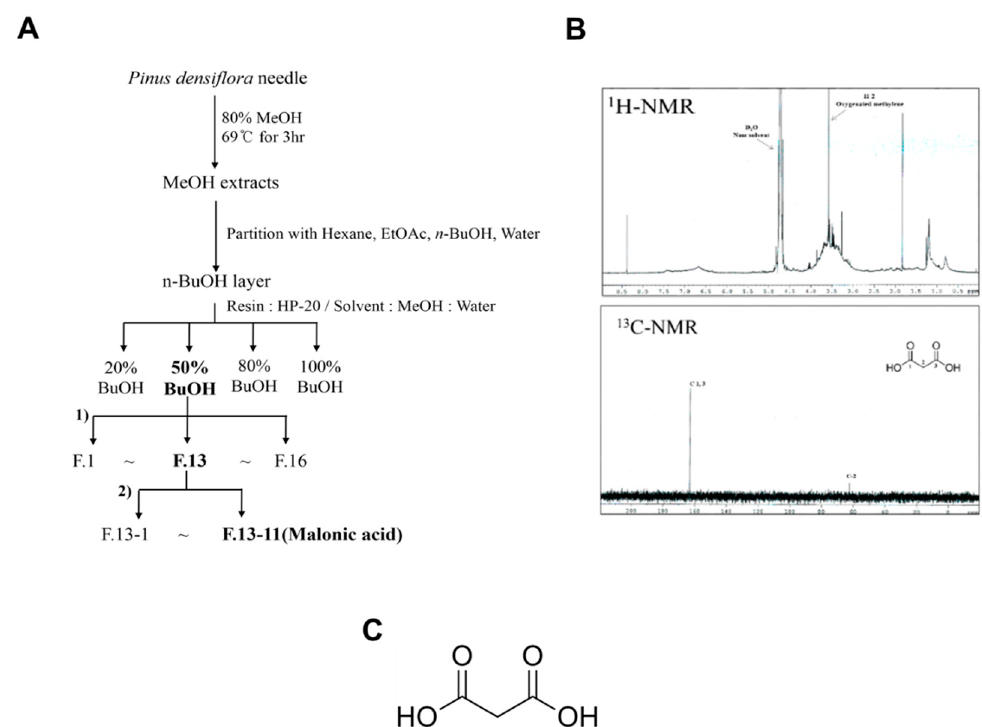
Figure 1. Isolation and purification of malonic acid (MA) from P. densiflora. ( A ) The P. densiflora n-BuOH layer has been separated and identified by nuclear magnetic resonance (NMR) to be MA. ( B ) 1H-NMR (300 MHz, D 2 O, δ H) 3.45 (2H, s, H-2); 13C-NMR (75 MHz, D 2 O, δ c) 167.5 (C-1,3), 62.2 (C-2). One methylene proton signal δ H 3.45 (2H, s, H-2), two carboxyl δ c 167.5 (C-1,3), and one methylene carbon signal δ c 62.2 (C-2) in 1H- and 13C-NMR spectra suggest that it is MA. ( C ) Chemical structure of